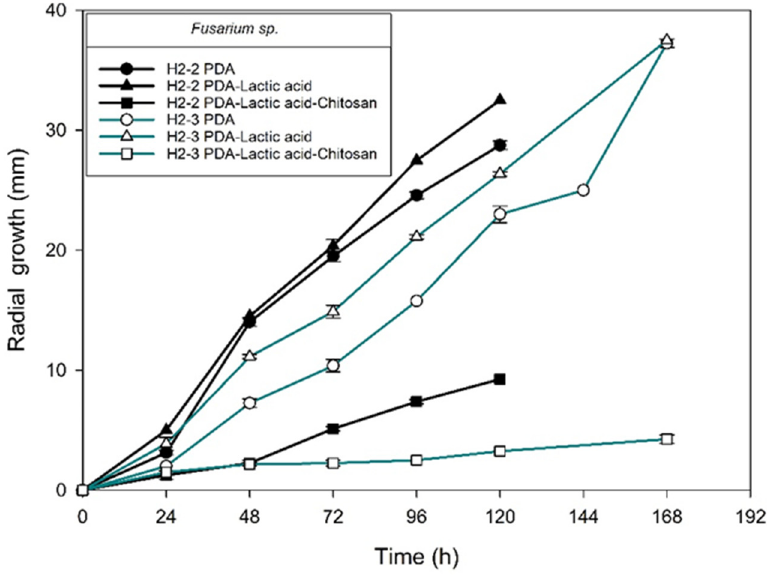
Figure 9. Fusarium sp. isolates from anthracnose of mango. Kinetics of radial growth (mm) in medium PDA, PDA-lactic acid (0.05 M), and PDA-lactic acid (0.05 M) with 1 g L − 1 chitosan at 25 °C.